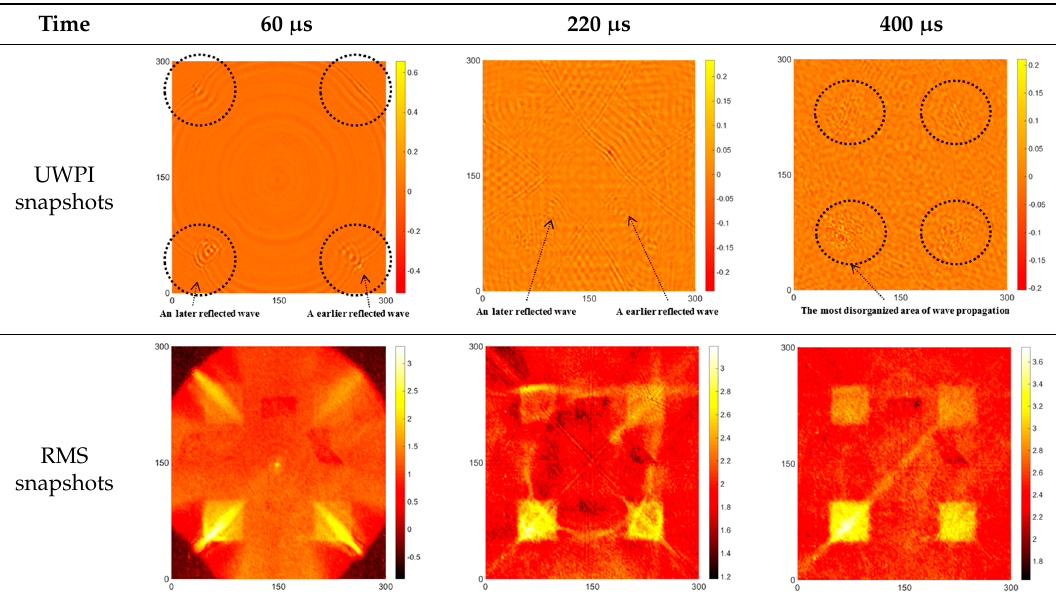
Table 5. UWPI and RMS snapshots of the Specimen 1 back side at 60 μ s, 220 μ s and 400 μ s (the unit of x and y axis: mm).